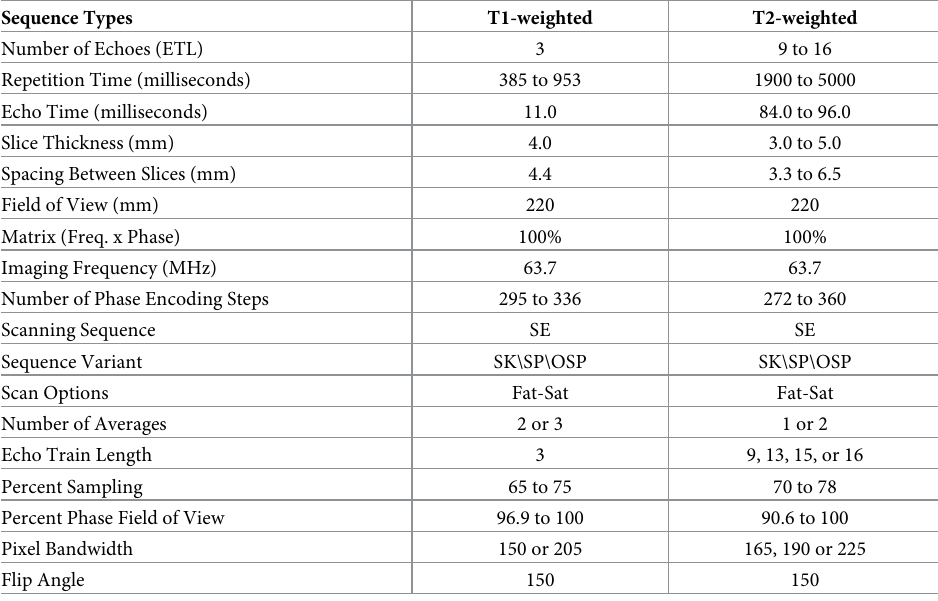
Table 1. The range of acquisition parameter values used during traverse MRI